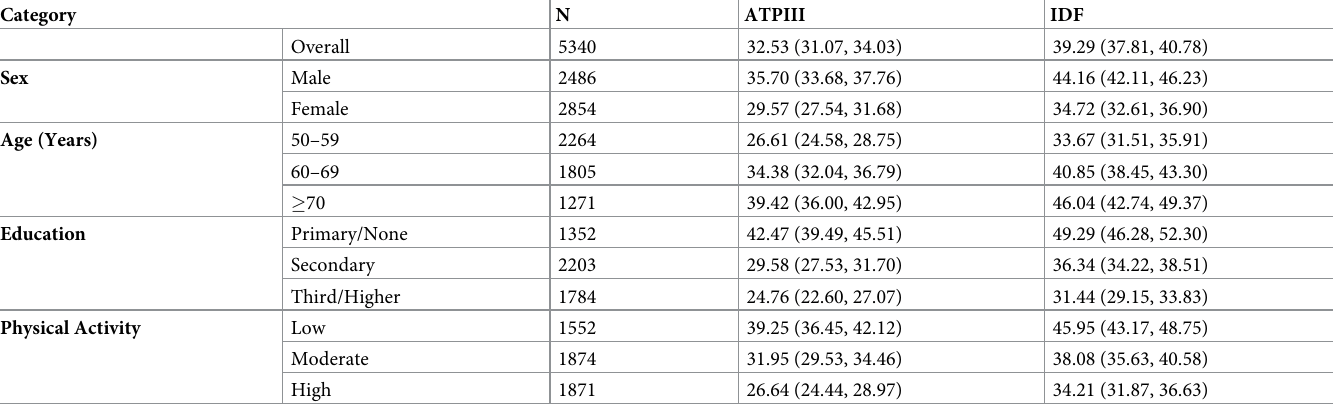
Those with MetS had higher smoking histories, were frailer, with more comorbidities including higher usage of anti-depressants. Those with MetS also had worse renal function, higher levels of inflammation, lower levels of vitamin D, and while they had lower LDL levels, those with MetS had higher ratios of LDL to HDL (Table 4). Table 3. Weighted prevalence of metabolic syndrome in older adults in Ireland overall and by subgroups of sex, age, educational attainment, and physical activity levels.